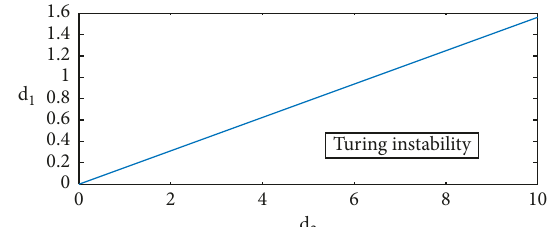
in the continuous